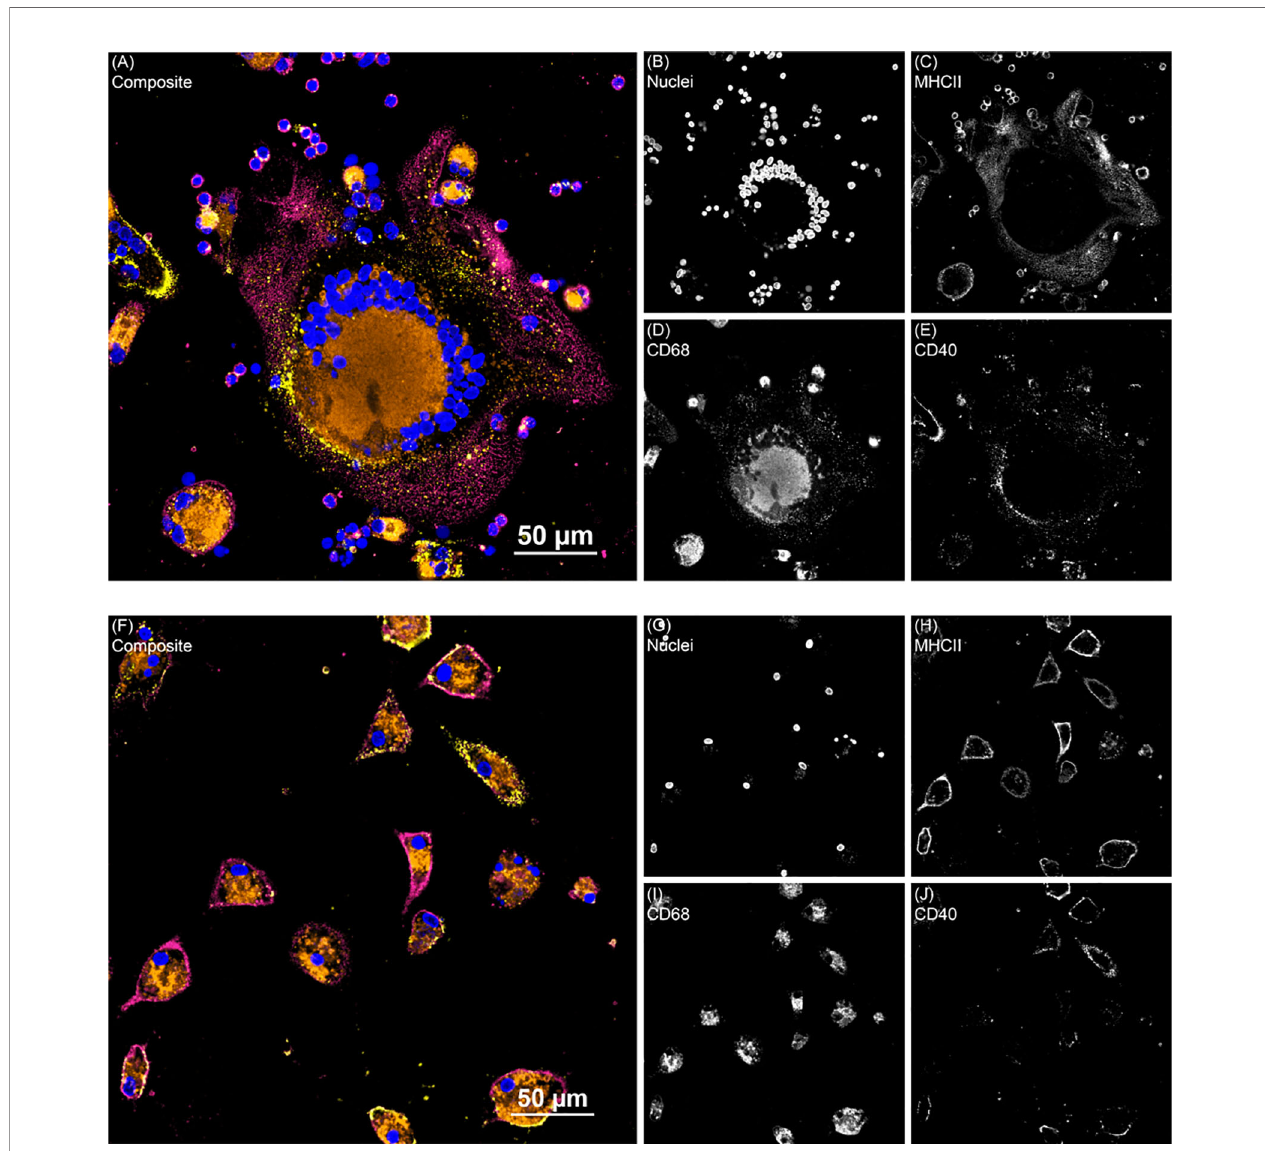
FIGURE 5 | Two representative fl uorescence images from the monocyte derived macrophage activation marker experiment. (A) Shows giant cell formation from a subclinical cow MDM sample treated with 25(OH)D 3 and (F) shows clinical cow untreated MDMs. Composite images show all channels. (B, G) DAPI counterstain was used to detect nuclei (blue) and was excited on the 405 nm laser. (C, H) MHCII (magenta) was labeled with an AF488 secondary antibody and excited with the 488 nm laser. (D, I) CD68 (orange) was labeled with an AF594 secondary antibody and excited on the 561 nm laser. (E, J) CD40 (yellow) was labeled with a NeutrAvidin DyLight 650 tertiary antibody and excited on the 640 nm